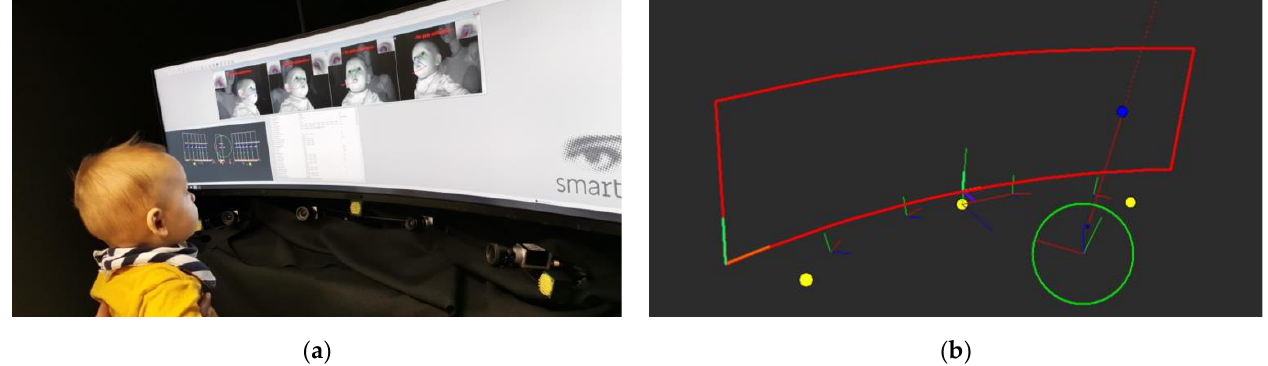
Figure 1. ( a ) Photographic representation of the apparatus adopted in this study. The eye-tracking system, including four cameras and three infrared flashes, was positioned below the display monitor. In this picture, the participant was ready for the system calibration step; ( b ) Image taken from the recording interface displaying the infant’s head (green circle) and their gaze position (blue dot) on the curved monitor (also defined as World Model; red area) during the experimental procedure. The yellow dots represent the three infrared flashes, and the four cameras were located in between those.